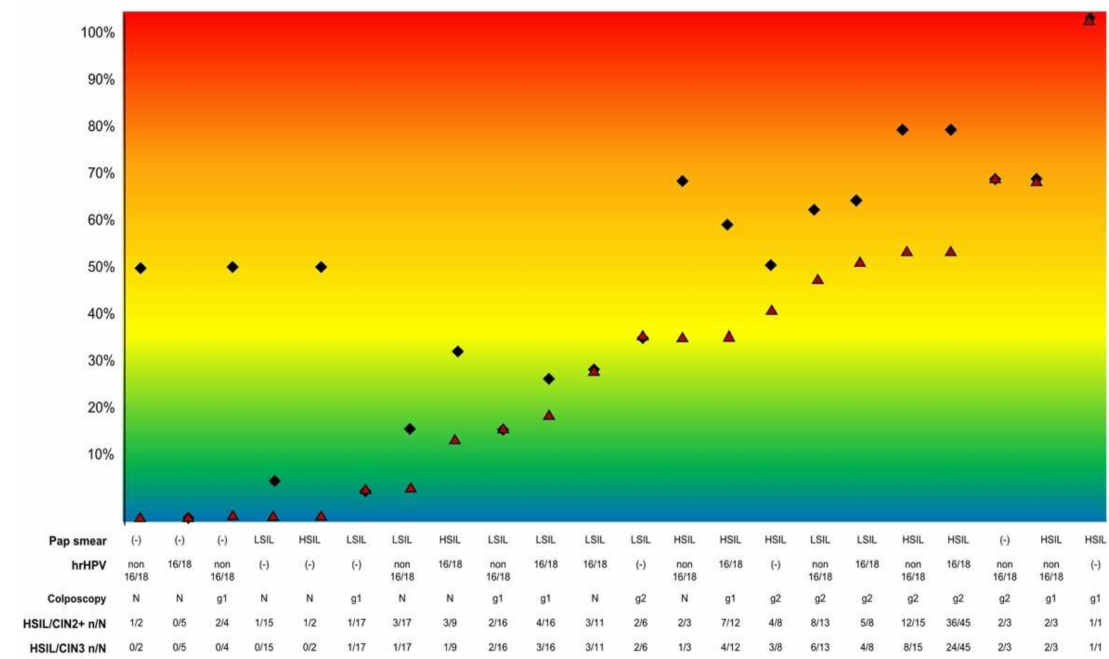
Figure 1. Prevalence of HSIL/CIN2+ (black diamonds) and HSIL/CIN3 (red triangles) according to the Pap test result, hrHPV testing, and colposcopic impression including the 231 women in whom the presence or absence of grade 2 colposcopy lesions could be confidently excluded or confirmed (all women with a type 1 or 2 transformation zone and women with a type 3 transformation zone with grade 2 findings). No women showed a negative Pap-test with HPV 16/18 infection or grade 1 or grade 2 findings in the colposcopy evaluation. Footnote: ( − ): negative; LSIL: low-grade squamous intraepithelial neoplasia (including atypical squamous cell of undetermined significance (ASC-US)); HSIL: high-grade squamous intraepithelial neoplasia; hrHPV: high-risk human papillomavirus; HSIL/CIN2+: high-grade squamous intraepithelial lesion/grade 2 or 3 cervical intraepithelial neoplasia or adenocarcinoma in situ. HSIL/CIN3: high-grade squamous intraepithelial lesion/grade 3 cervical intraepithelial neoplasia or adenocarcinoma in situ. N: normal colposcopy; g1: grade 1 findings; g2: grade 2